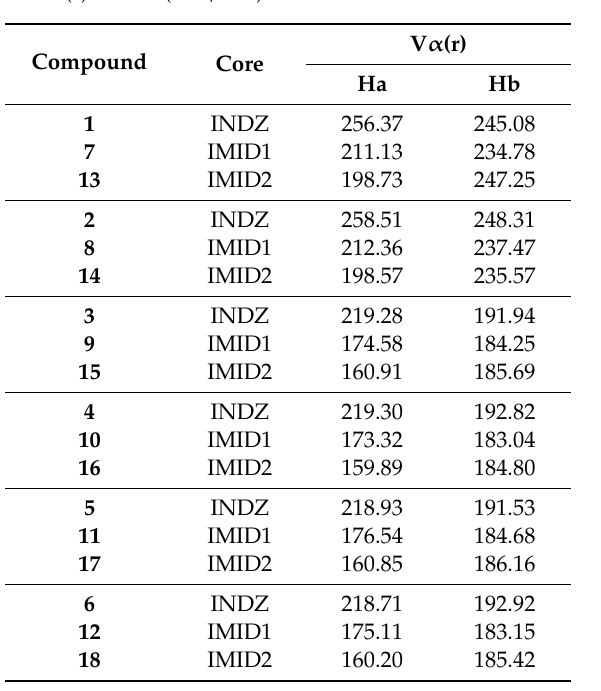
Table 4. V α (r) values (kcal / mol) of the core Ha and carboxamide